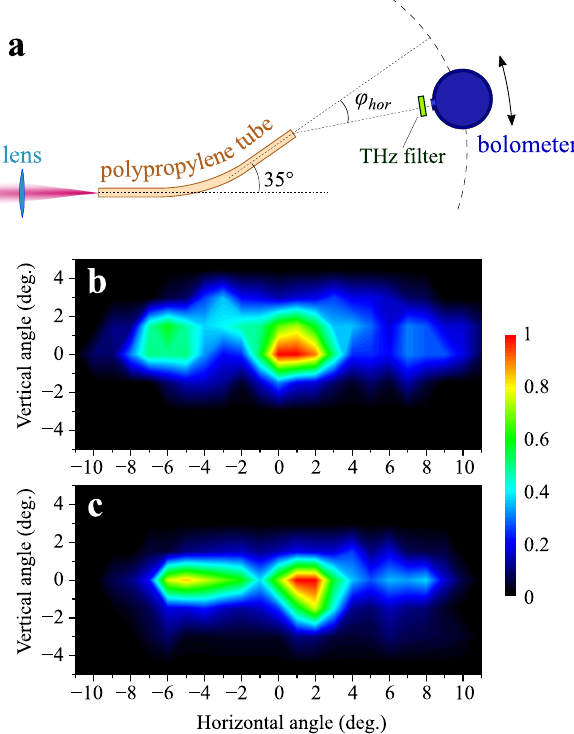
Figure 4. Scheme of the experiment with the bent pipe ( a ). Angular distribution of the radiation with frequencies of 0.5 THz ( b ) and 1 THz ( c ) passed through the bent